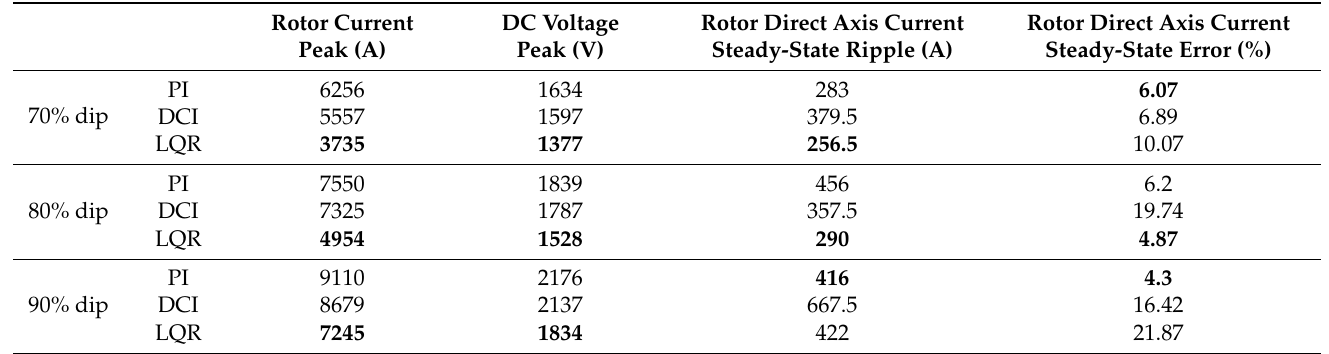
Table 11. Summary of results for PI and LQR applied to DFIG under symmetrical voltage dip.